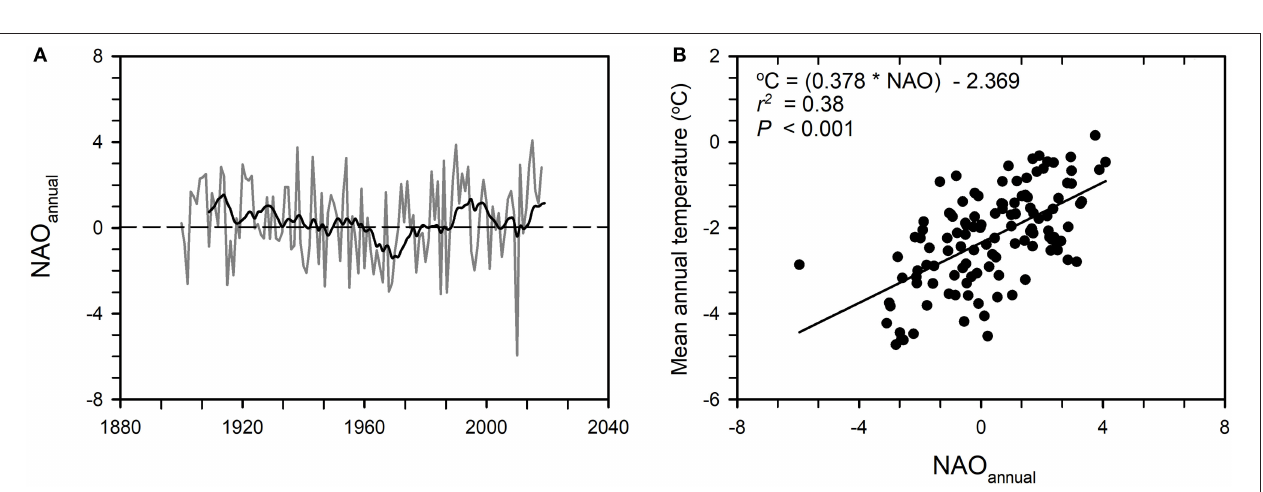
FIGURE 10 | Influence of large-scale climate on local weather. (A) Annual values of the North Atlantic Oscillation annual index 1900–2018 (NAO annual , gray curve). The trend is indicated by a 10-year running mean (black curve). (B) Relationship between NAO annual and the mean annual temperature over the reindeer winter pasture area of Finnmarksvidda ( Figure 7 ), 1900–2018. Each point represents one year. Data: Hurrell and National Center for Atmospheric Research Staff (2020), Norwegian Meteorological Institute.